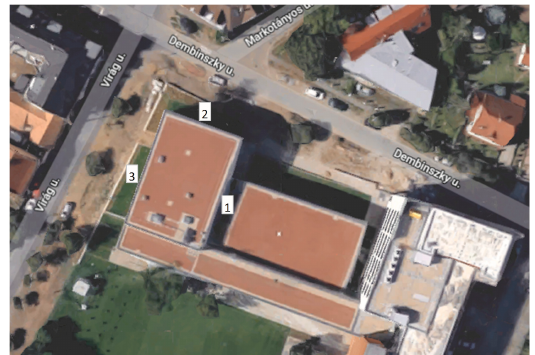
Figure 11. Measuring points outside the building (Source: https://www.google.com/maps/place/Debrecen).